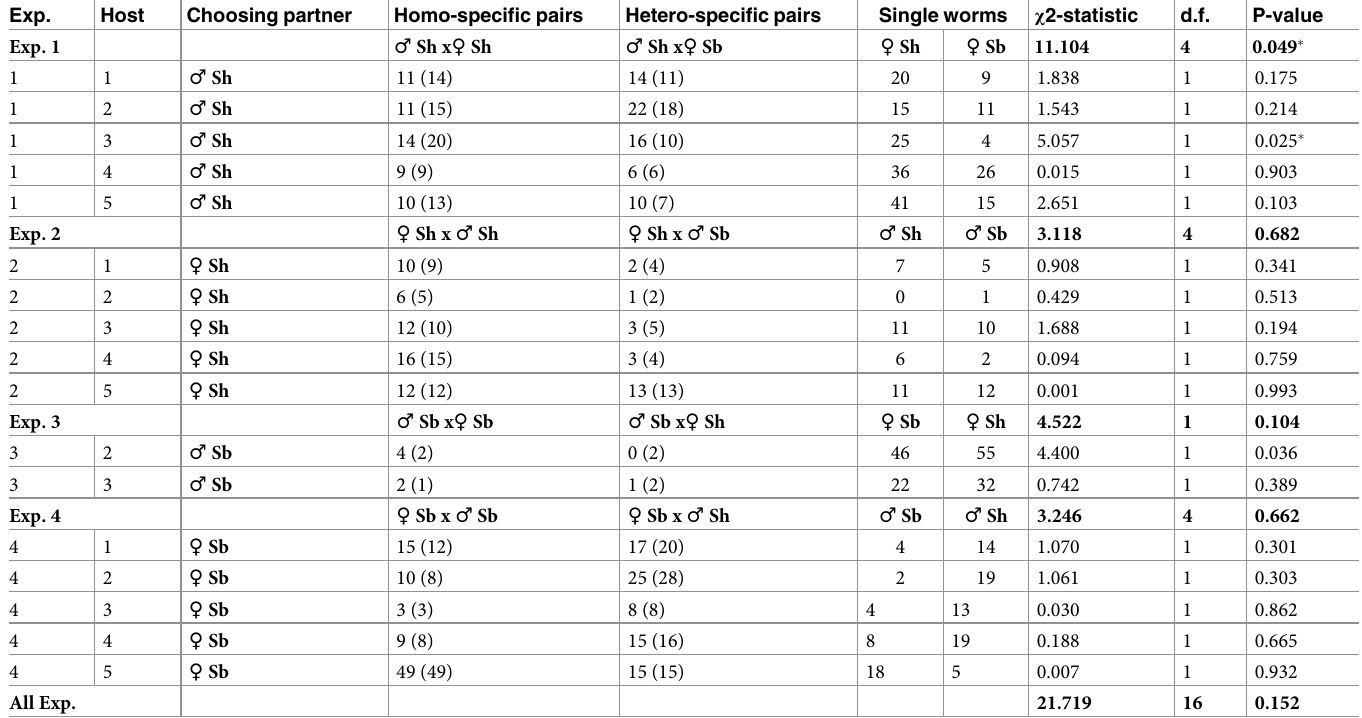
Table 2. Summarized information of experiments 1 to 4 (limited choice). For each experiment are displayed the sex and the species of the choosing partner (such as female choice or male competition), the number of observed homo- and hetero-specific pairs and the number of worms that remained single. Sh = S . haematobium and Sb = S . bovis . Expected number of pairs under random mating hypothesis is shown in brackets (see the statistics section in Materials and Methods for details). Chi-square sta- tistic, degree of freedom and P-value are given for each hamster, for each experiment and for all experiments combined. � indicates significant results at 5% level. In Exp. 3, worms from only two hamsters could be analysed, while others died prematurely (two hamsters) or presented too few numbers of paired worm (one hamster). Exp.